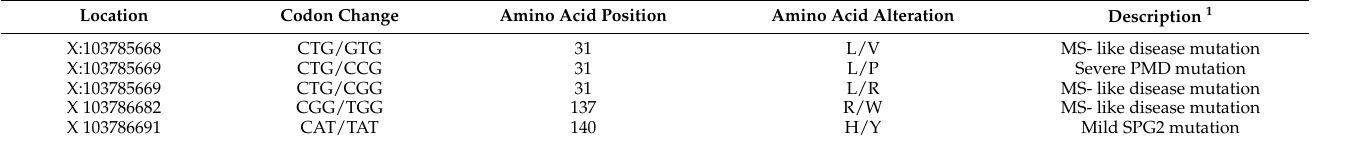
Table 1. PLP1 variants. This mutation was selected as the closest mutation to residue 137 known for PLP1 . Location Codon Change Amino Acid Position Amino Acid